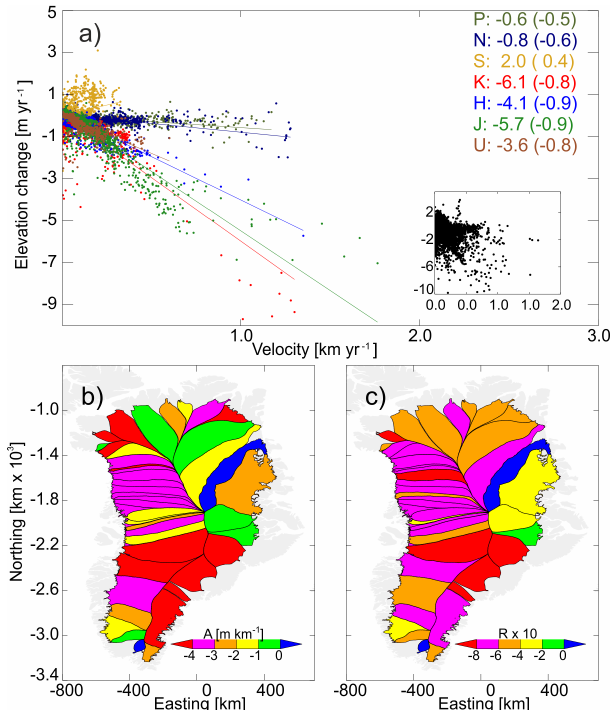
Figure 2. (a) : d H /d t versus velocity for selected basins: Petermann glacier (P), Jakobshavn Isbræ (J), Storstrømmen (S), Kangerd- lugssuaq (K), Helheim glacier (H), Upernavik (U), and Nioghalvf- jerdsbræ (N), using all ICESat data (2003–2009). The slope of the linear regression is shown as well with the corresponding r in brack- ets. The inset shows the scatter plot for all of Greenland. Note that the x axis is limited at 3kmyear − 1 for clarity. The few points that have higher velocities are included in the relationship but not in the plot. (b) and (c) show the slope and Pearson’s correlation coeffi- cient (multiplied by 10), respectively, for all 38 Greenland drainage